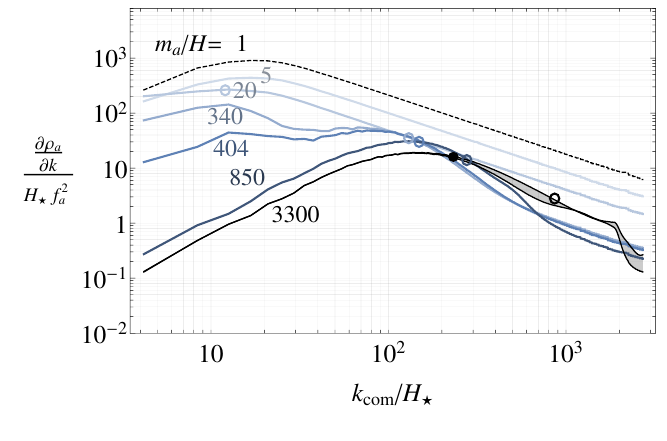
Figure 25: The time evolution of the axion spectrum ξ = 1000, α = 8, x = 10. Different times are represented by m (cid:63) log (cid:63) 0 Results are shown at the initial time t (cid:63) (dashed line), during the relativistic regime (second line from the top), during the transient, and at the final time once the IR modes are evolving nonrelativistically (black line). The analytic fit for time t (cid:96) when ρ ≈ V corresponds to m ( t ) / H ( t ) ≈ 680. Empty dots indicate the momentum (cid:96) (cid:96) a IR equal to m at any given a